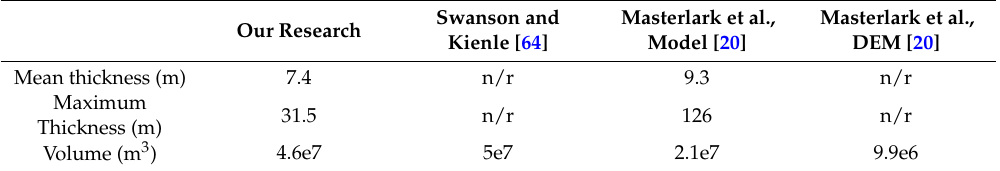
Table 2. Comparison of previously determined values for mean thickness, maximum thickness, and volume of PFDs from Augustine’s 1986 eruption. Unreported values are shown as n/r. Swanson and Masterlark et al., Masterlark et al., Our Research Kienle [64] Model [20] DEM [20] Mean thickness (m) 7.4 n/r 9.3 n/r Maximum 31.5 n/r 126 Thickness (m) Volume (m 3 ) 4.6e7 5e7 2.1e7